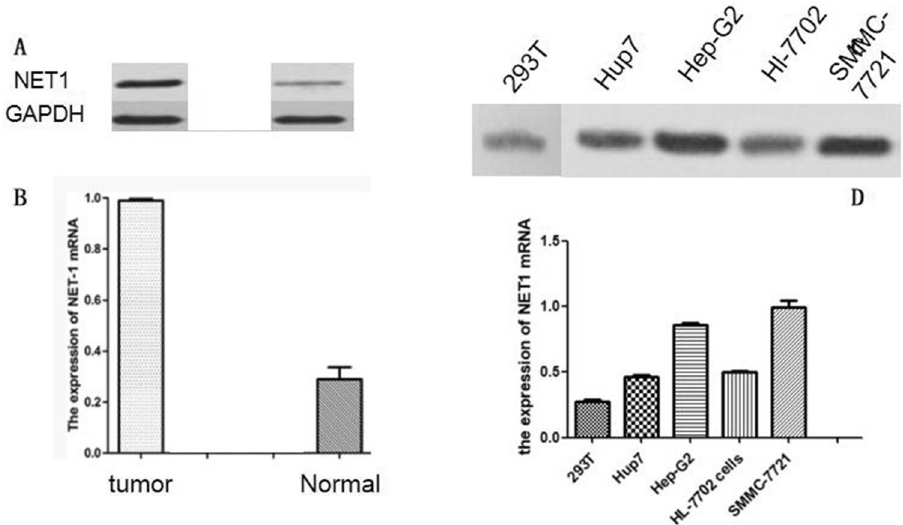
Figure 1. Aberrant expression of NET1 in hepatocellular carcinoma. ( A , B ) NET1 was significantly increased in hepatic tumor compared to the normal tissue. ( C , D ) NET1 expression was obviously elevated in hepatic cancer cell lines compared to that in HEK293 cell line.